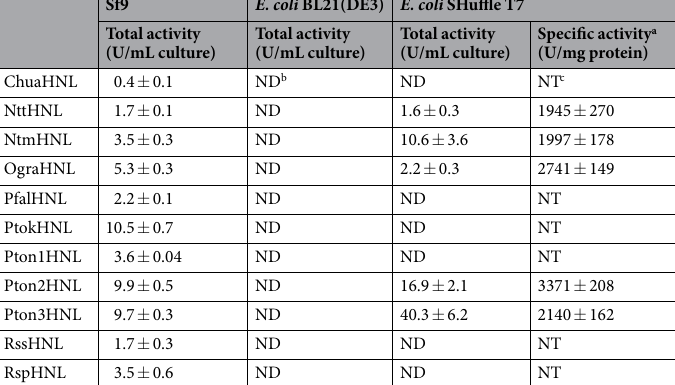
Table 2. Heterologous expression of HNL genes in insect cells and E. coli . a Specific activity was determined using purified enzymes, b ND; Not detected, c NT; Not